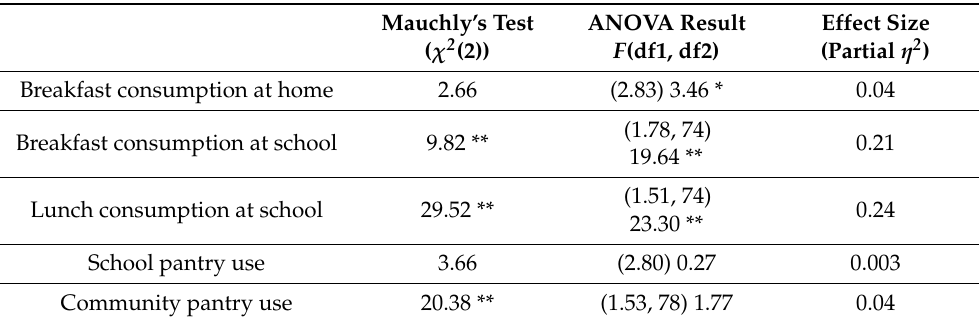
Table 5. Repeated-measures ANOVA omnibus results with Mauchly’s test of sphericity.